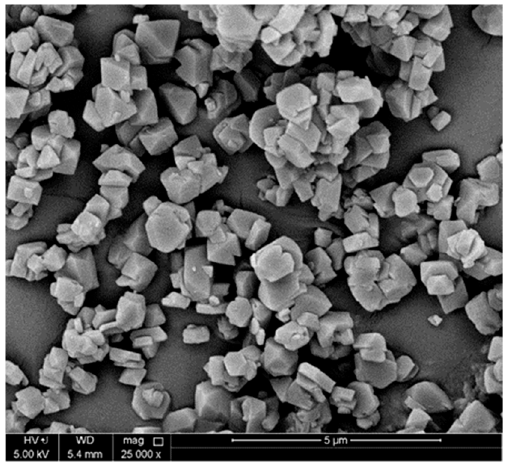
Figure 4. SEM of SIFSIX-3-Ni.